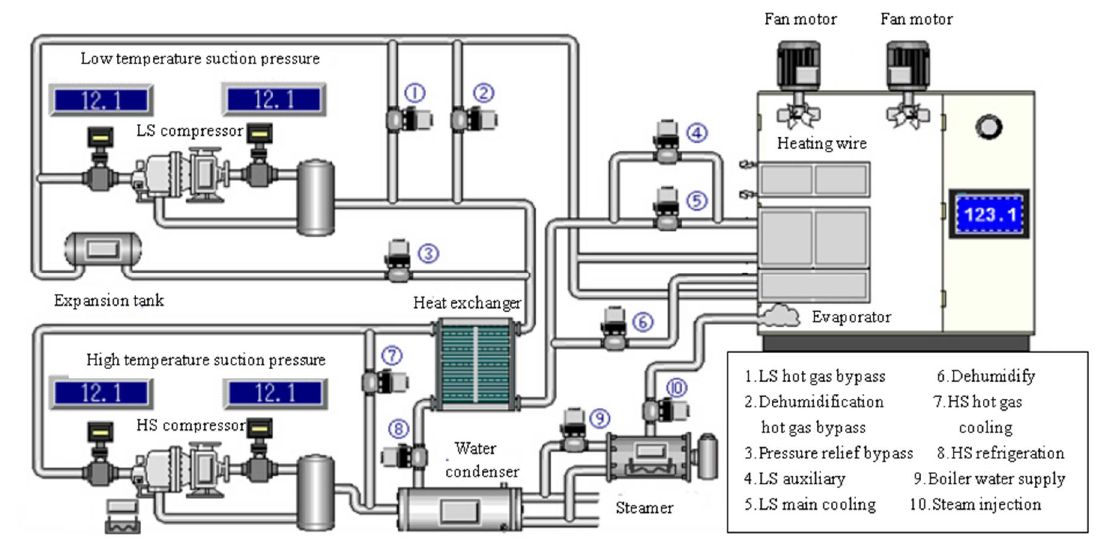
Figure 5. The framework of the environment system.